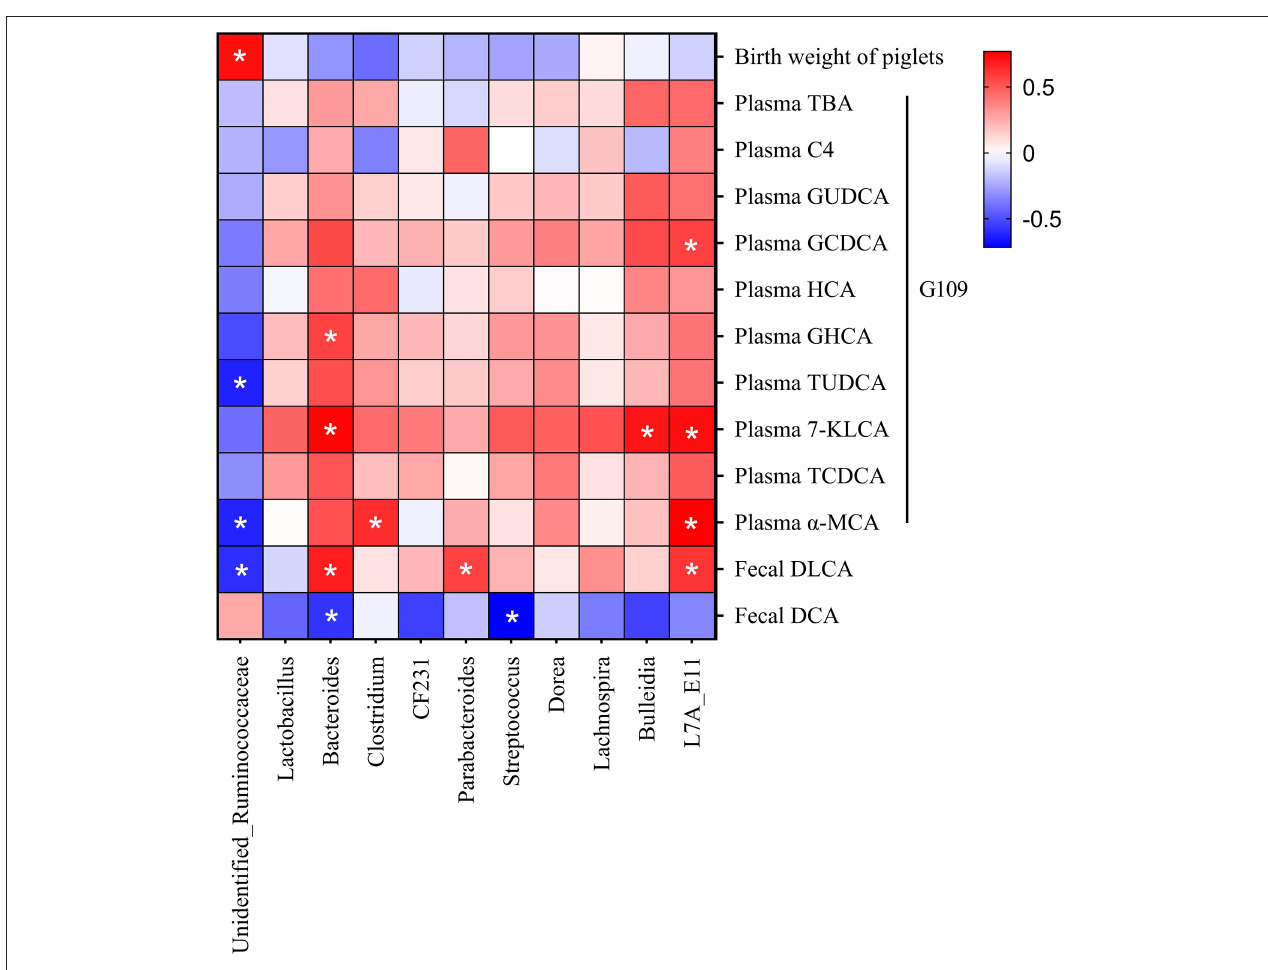
FIGURE 6 | Correlation between microbiome and parameters of bile acid metabolism, and reproductive performance of sows. Red indicates positive correction, and blue indicates negative correction. * p <